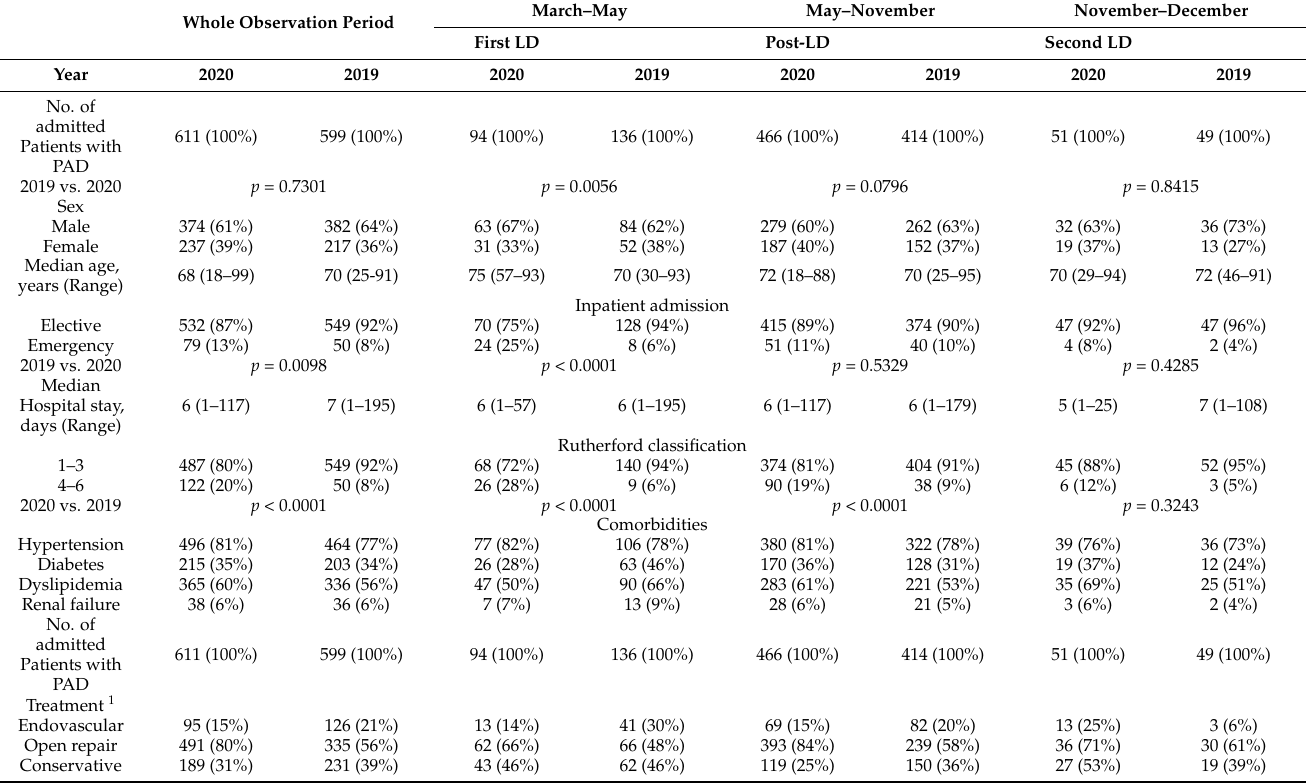
Table 2. Characteristics of patients with peripheral artery